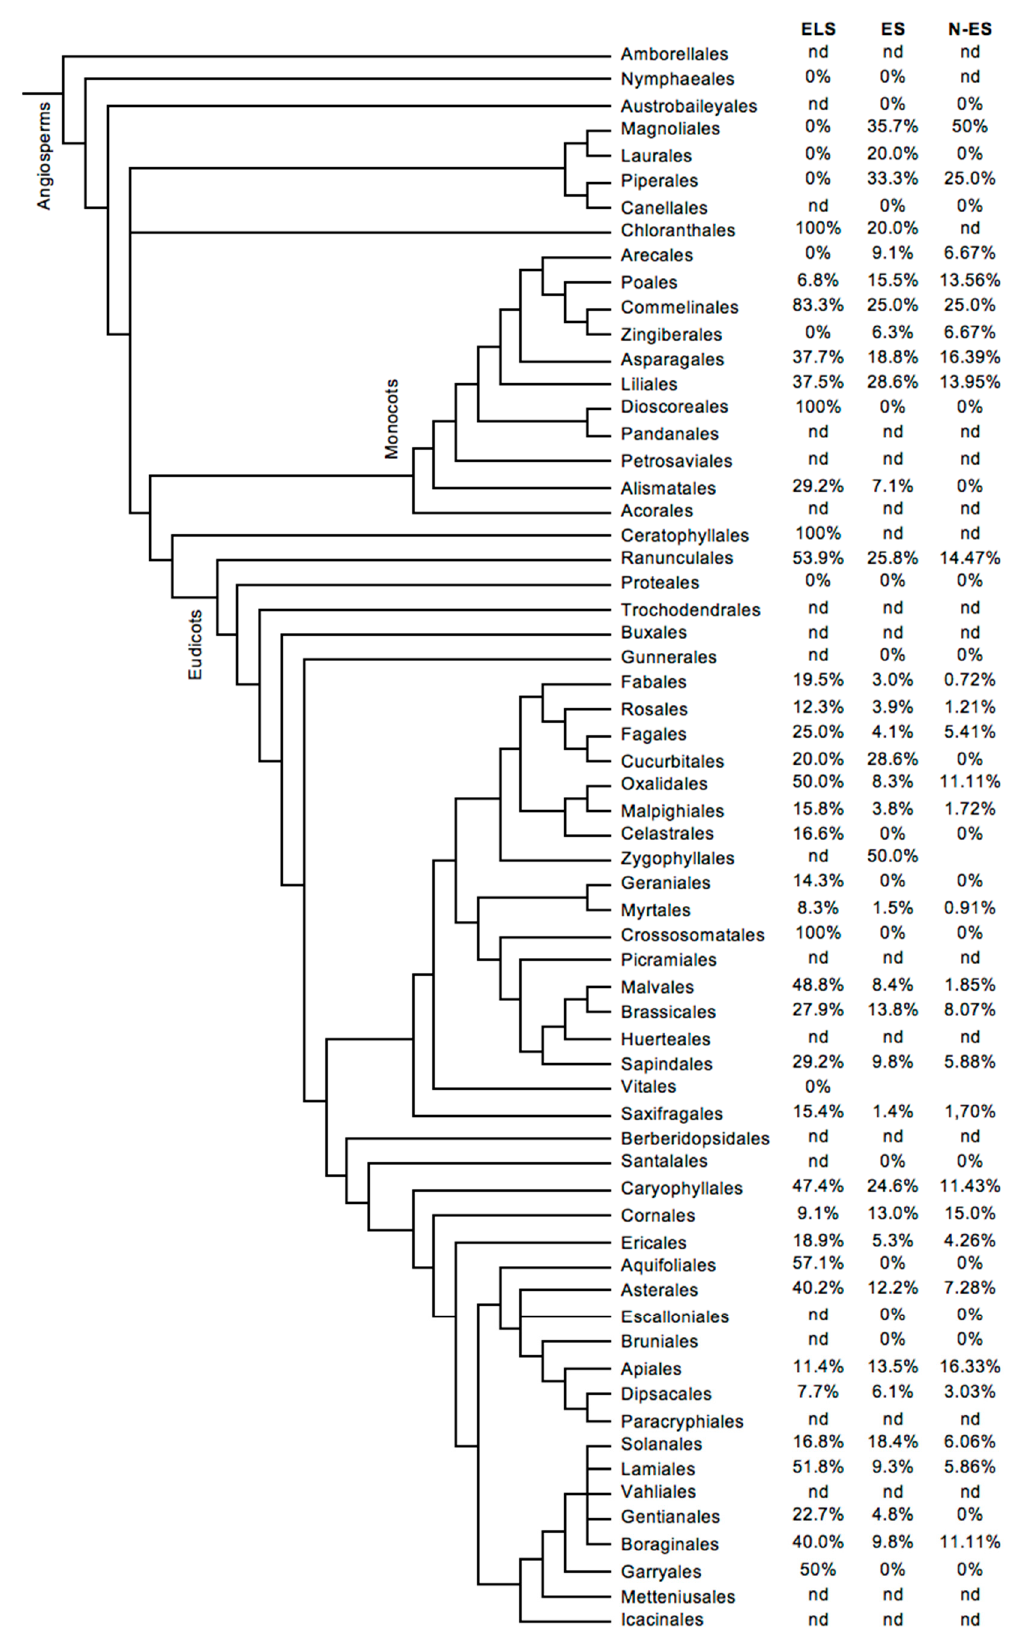
Figure 3. Angiosperms: Indication of the frequency of ecdysteroid-containing species within the orders of angiosperm plants. The classification is according to APGIV [27] and the data concerning the